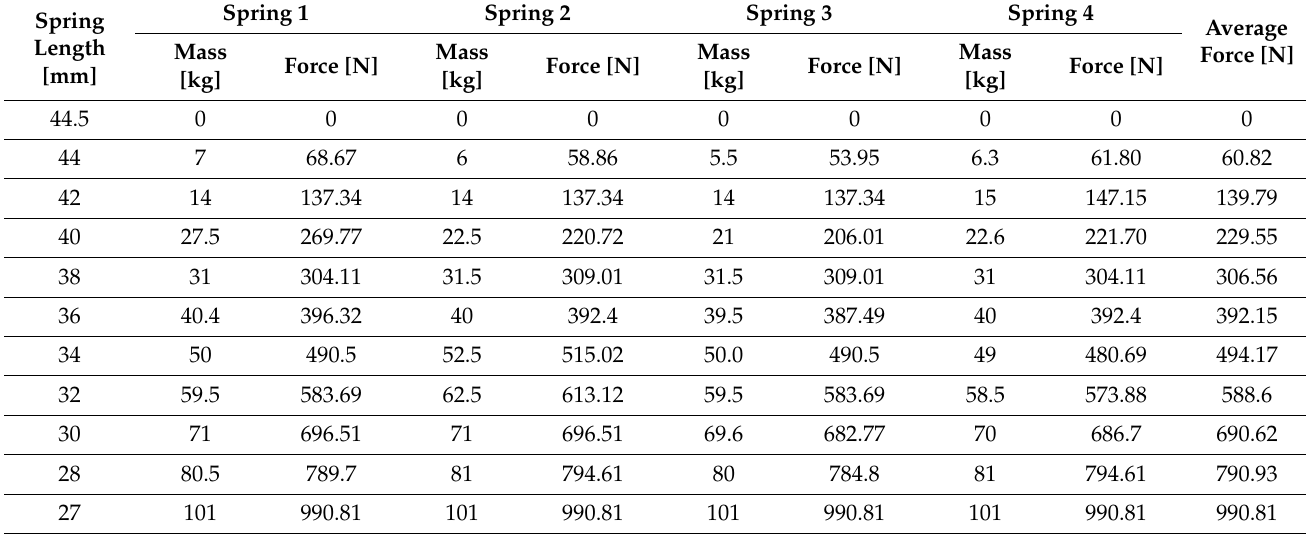
Table 4. Determination of the elastic characteristic of the valve spring.